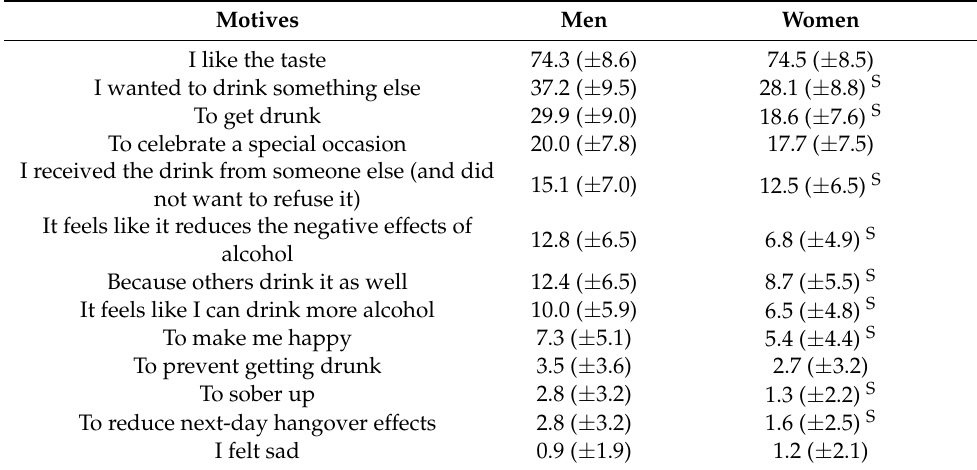
Table 8. Motives for alcohol mixed with energy drink (AMED) consumption among men and women.